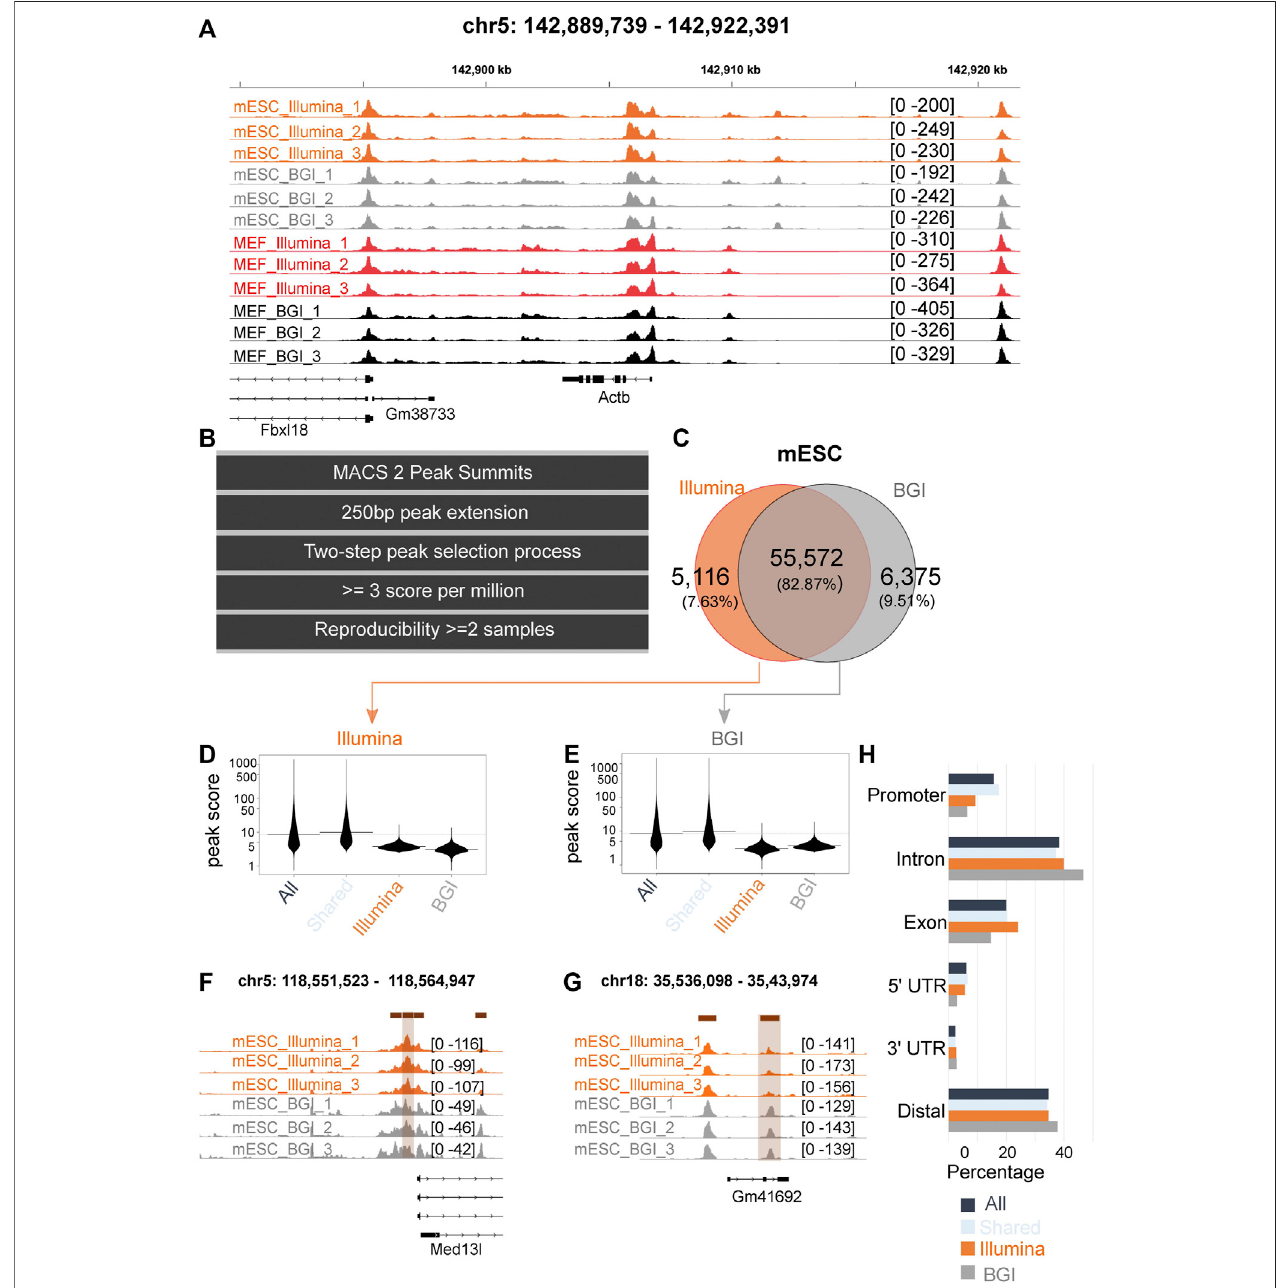
FIGURE2| Comparisonofpeaksidenti fi edindatafrombothplatforms. (A) TracksfromallsamplesatthelocusoftheActbhousekeepinggene. (B) Computational work fl ow to identify high-con fi dence peaks across the samples of one experimental group (e.g., for three biological MEF replicate samples sequenced on the Illumina platform). (C) Venn diagram for high-con fi dence peaks (across the biological replicates) identi fi ed in mESC data sequenced on Illumina and BGI platform. (D,E) Peak scores of Illumina and BGI speci fi c peaks relative to the scores of all peaks in the data set and relative to peaks shared by data sets. (F,G) Tracks of representative Illumina and BGI speci fi c peaks. (H) Genomic context of high-con fi dence mESC peaks (displayed for all peaks, peaks that are shared/overlap between both data sets, and high-con fi dence peaks only identi fi ed in the Illumina or BGI data set).